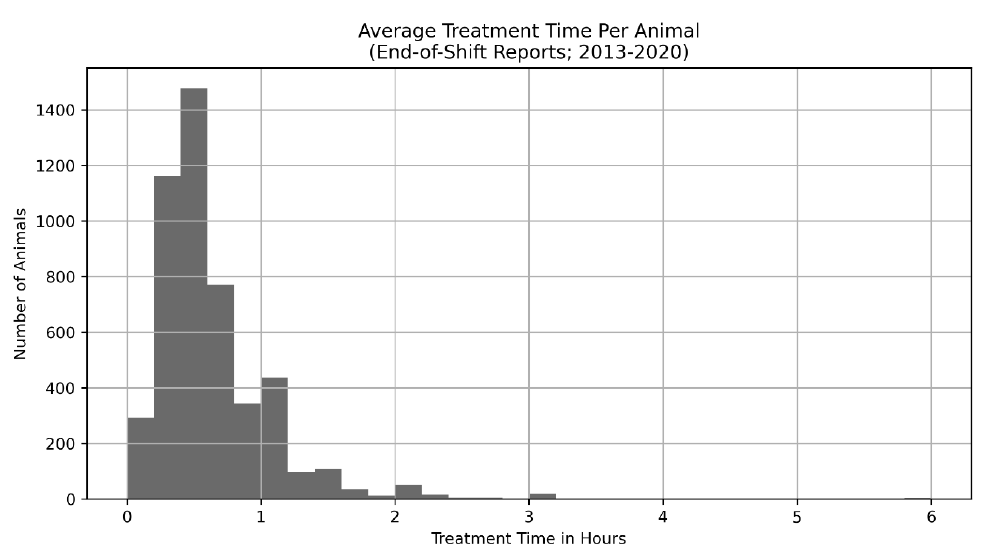
Figure A1. Distribution of average treatment times per dog per shift (per the End-of-Shift Reports; N days = 2474; 2013–2020). The mean treatment time was 0.63 h per treatment. Two treatments per day were performed per animal.